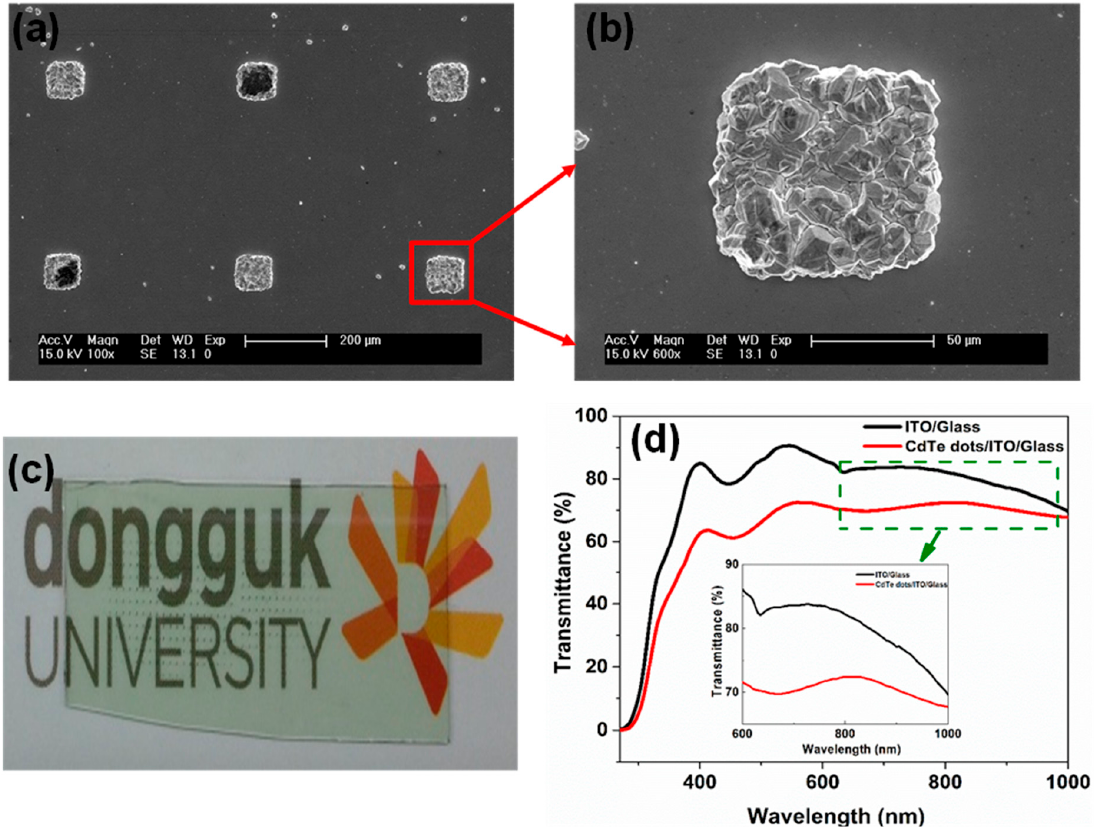
Figure 6. ( a ) SEM image of CdTe microdots arrays grown on Bi coated ITO substrate; ( b ) Enlarged version of the single microdots; ( c ) Photograph of the arrayed CdTe microdots films; ( d ) Transmittance spectra of CdTe microdots arrays film.